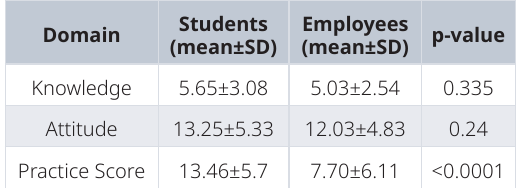
Table 8. Independent t-test results for knowledge, attitude, and practice comparisons between students and